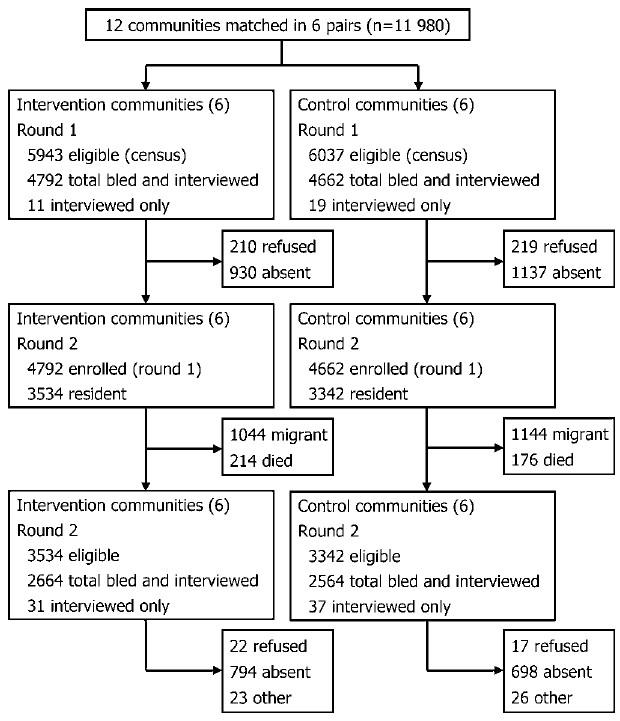
Figure 2. Flow-Chart Comparing Participation and Follow-Up Rates in the Intervention and Control Communities Individuals enrolled in round 1 and still resident in the study communities were considered eligible for participation in round